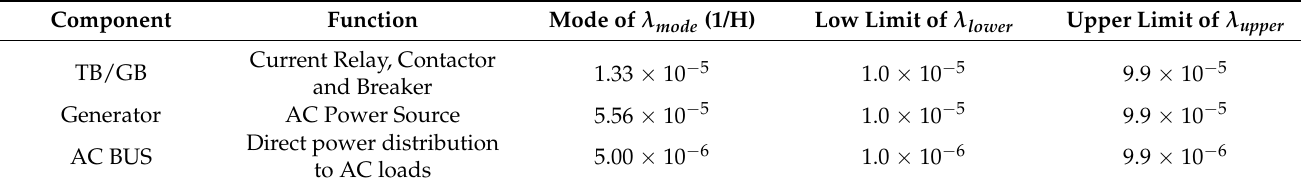
Table 3. Failure rate of each component of the AEPS